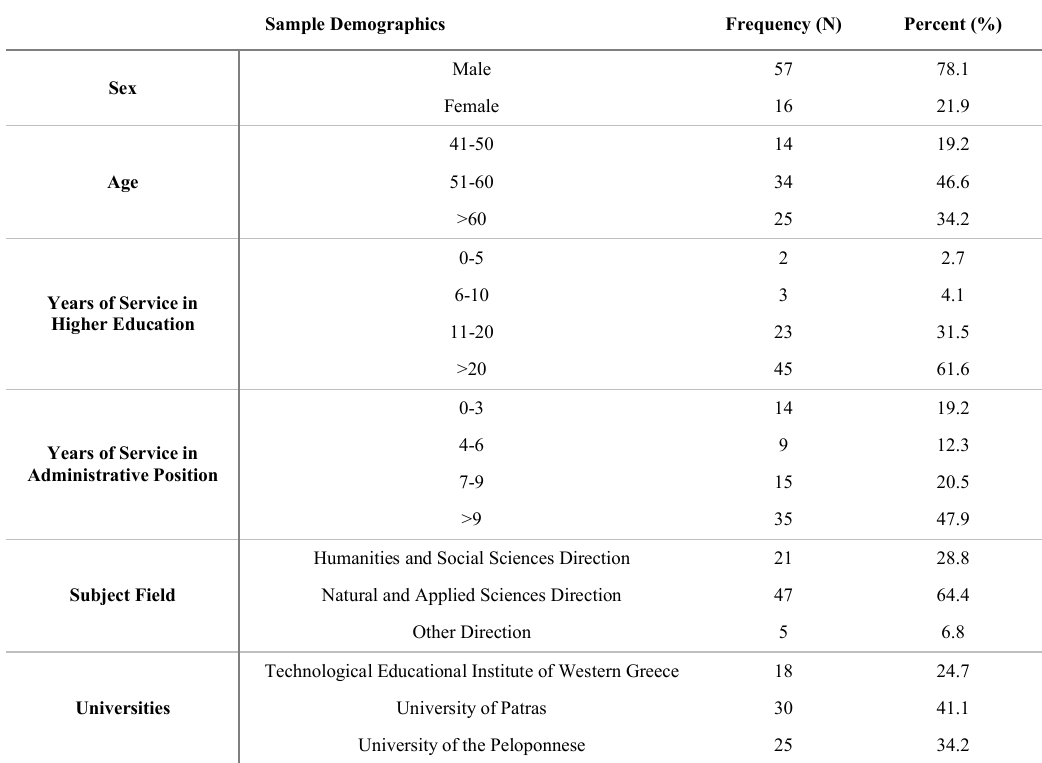
Table 1. Sample demographics